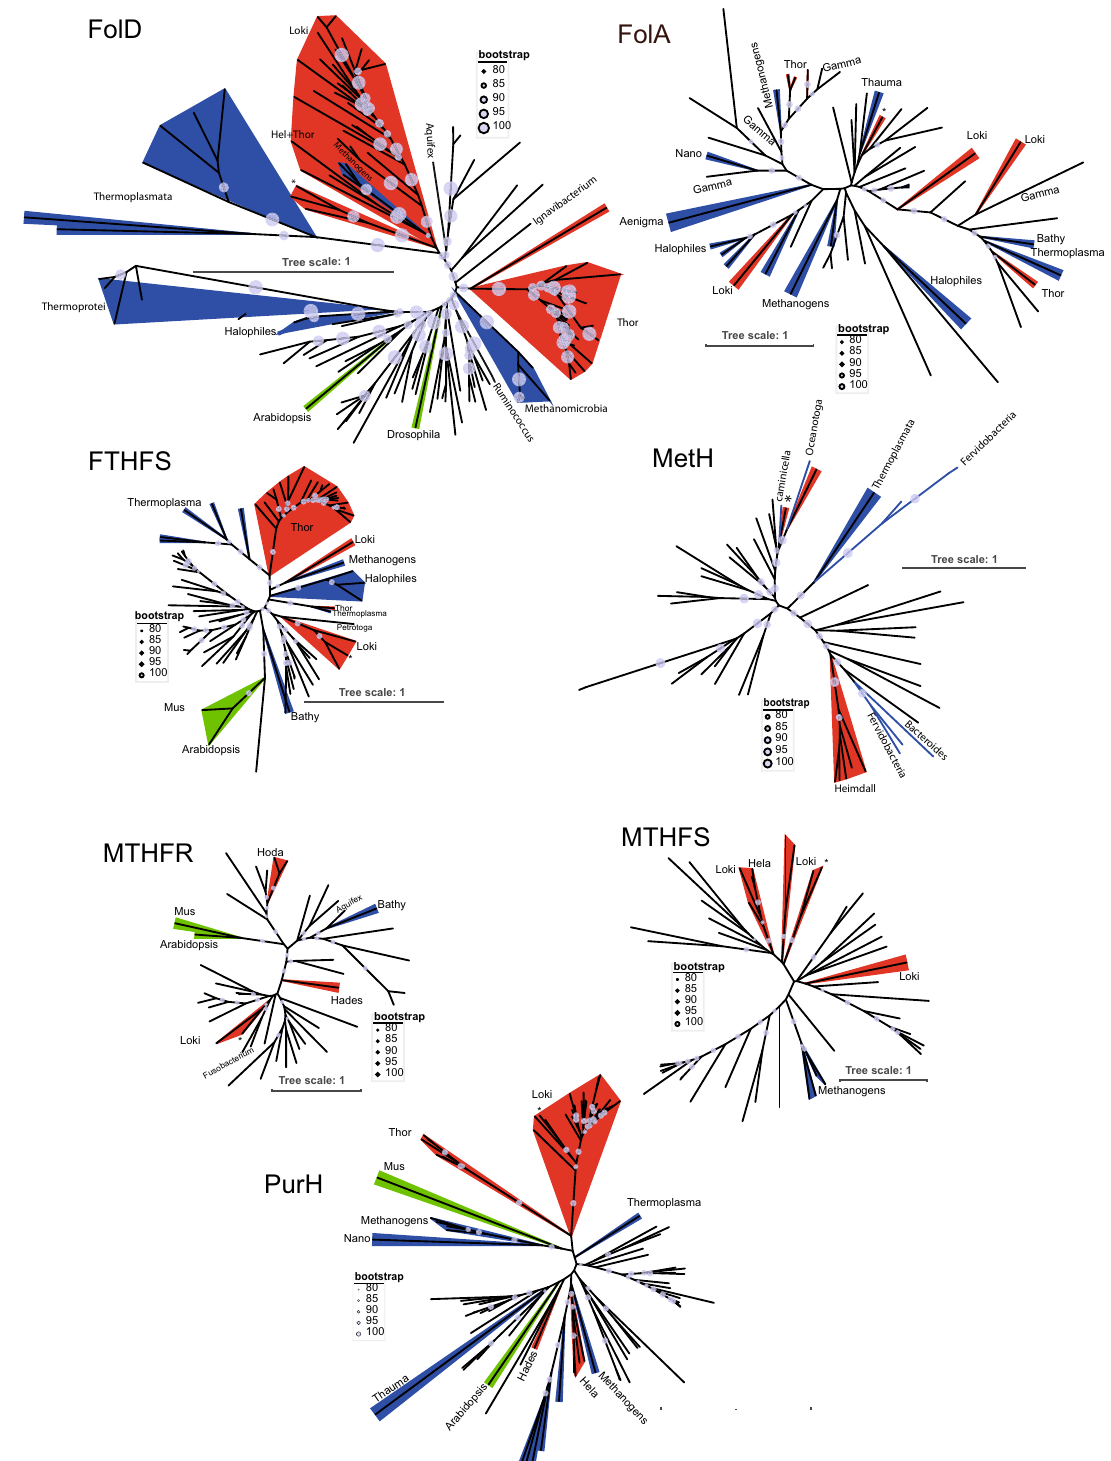
Fig. 8 | Unrooted Maximum likelihood phylogenetic tree of the Asgard folate- related proteins. FolA (83 sequences, alignment of 153 amino acids), FolD (130 sequences, alignment of 244 amino acids), MTHFS (56 sequences, alignment of 149 amino acids), FTHFS (79 sequences, alignment of 509 amino acids), PurH (94 sequences, alignment of 437 amino acids), MetH (47 sequences, alignment of